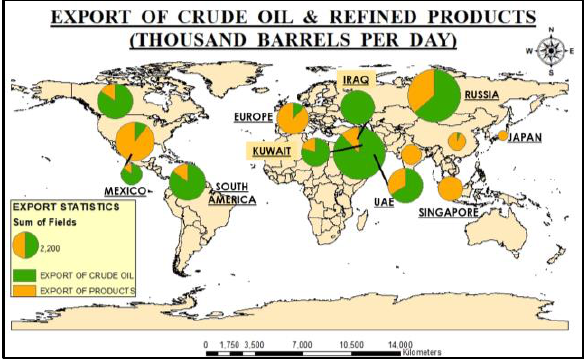
names of these countries are annotated next to the pies.